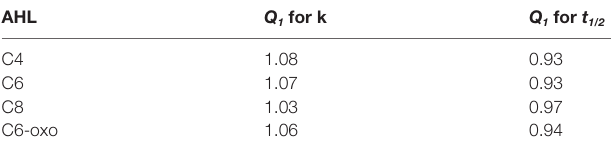
TABLE 3 | Temperature-dependent factors for hydolysis rate k and half-life time t 1/2 for a + 1°C temperature increase derived from data by Yates et al. (2002). AHL Q 1 for k Q 1 for t